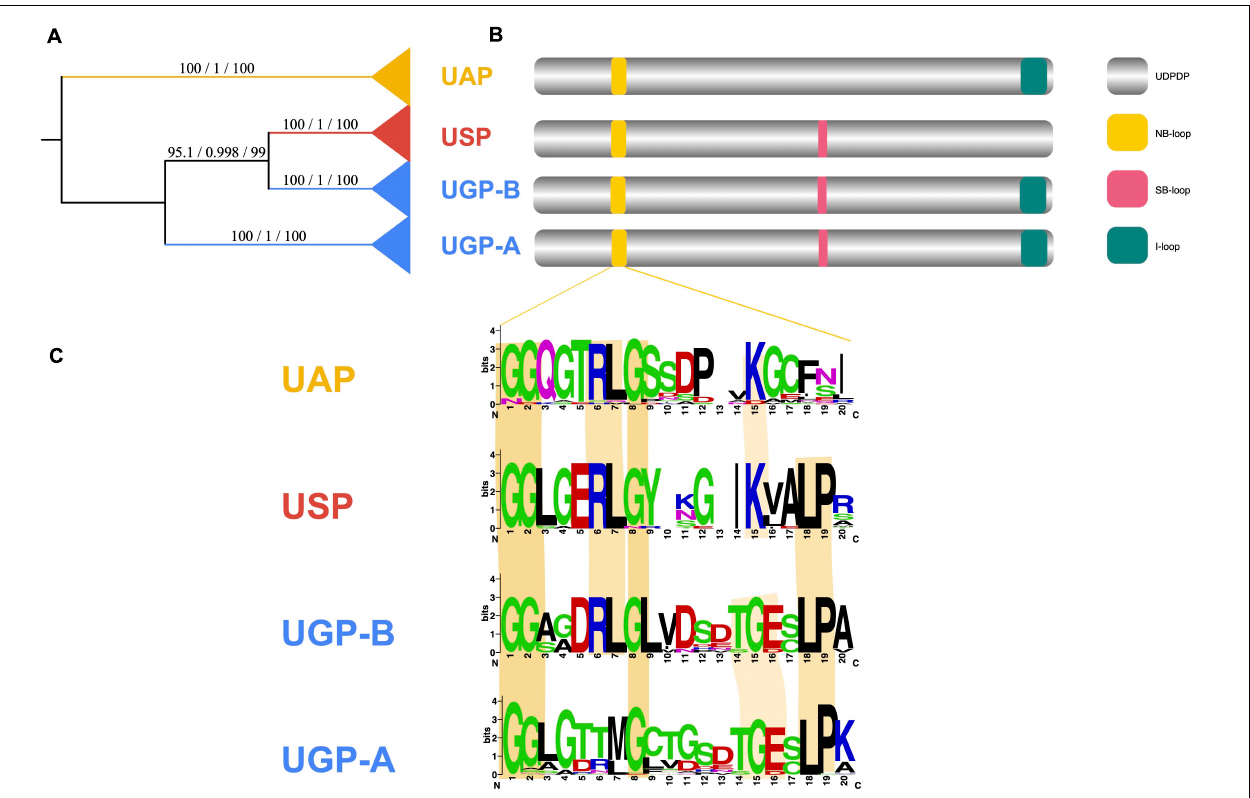
FIGURE 6 | UDP glucose pyrophosphorylase (UDPGP) domain classification and conservation of functional motifs. (A) Phylogram showing the classification of the UDPGP gene family with the major clades labeled. (B) Typical UDPGP structure consists of an NB-loop, SB-loop, and I-loop with the approximate positions. (C) Conservation of the NB-loop functional motifs in different